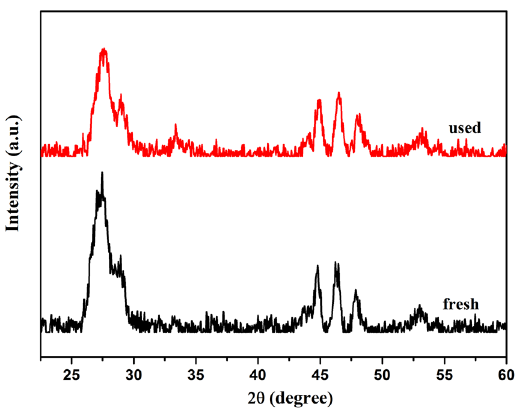
Figure 12. XRD patterns of CdIn 2 S 4 photocatalyst before and after the photocatalytic